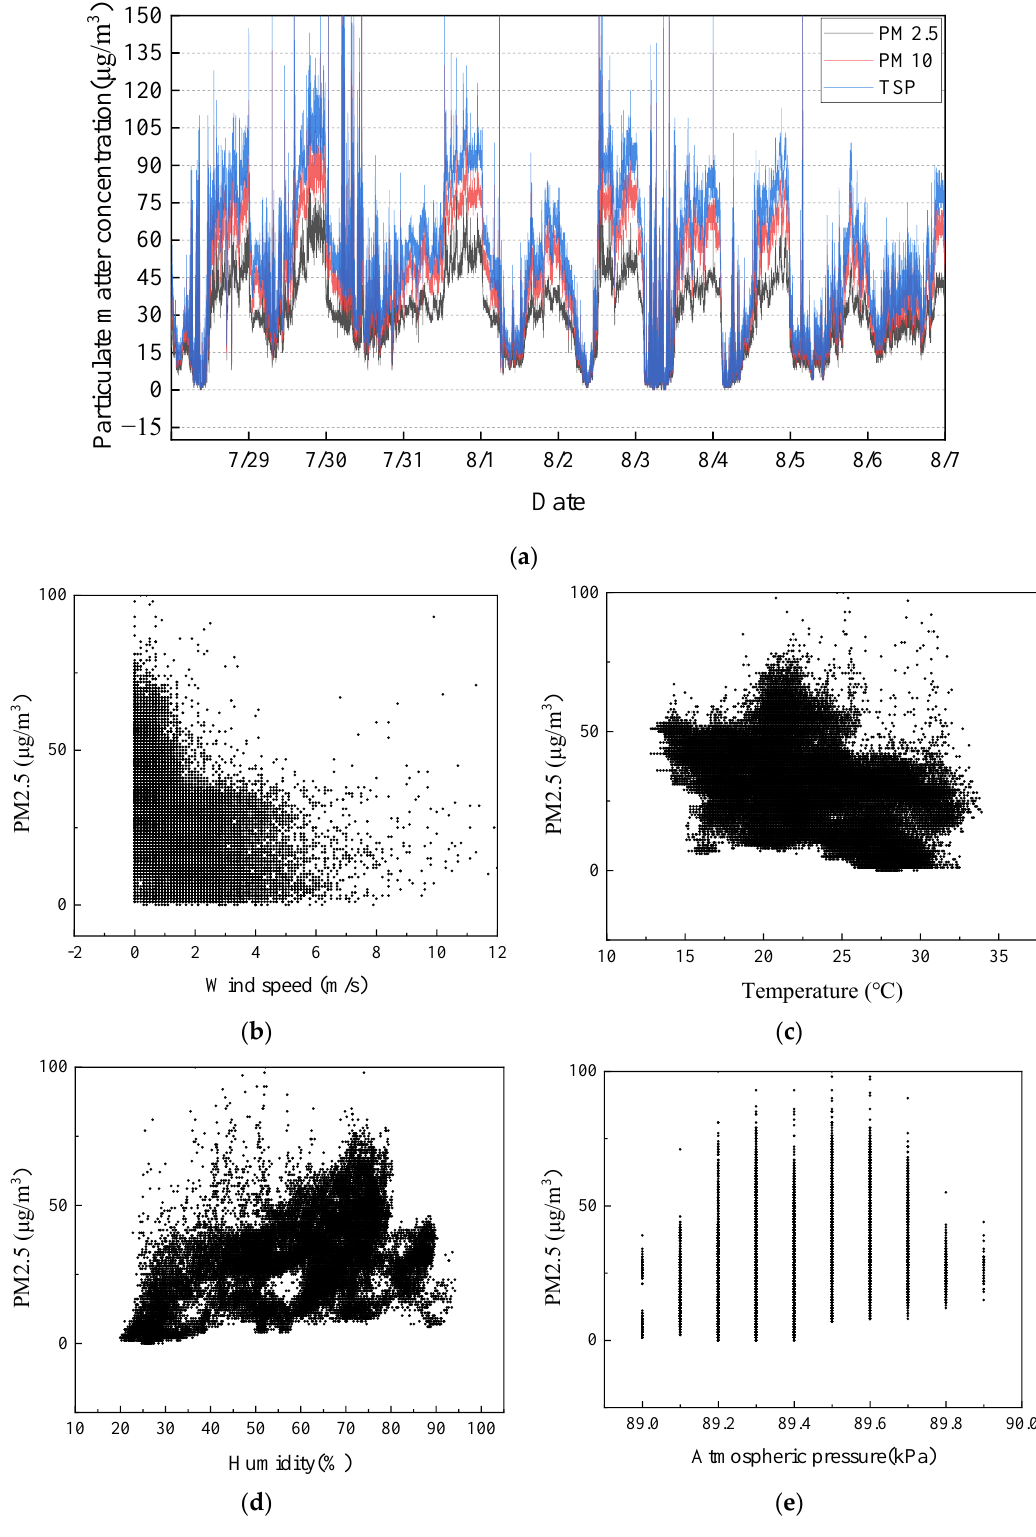
Figure 2. Measured data from 7/28/2020 to 8/7/2020: ( a ) dust concentration; ( b ) wind speed; ( c ) temperature; ( d ) humidity; ( e ) atmospheric pressure.